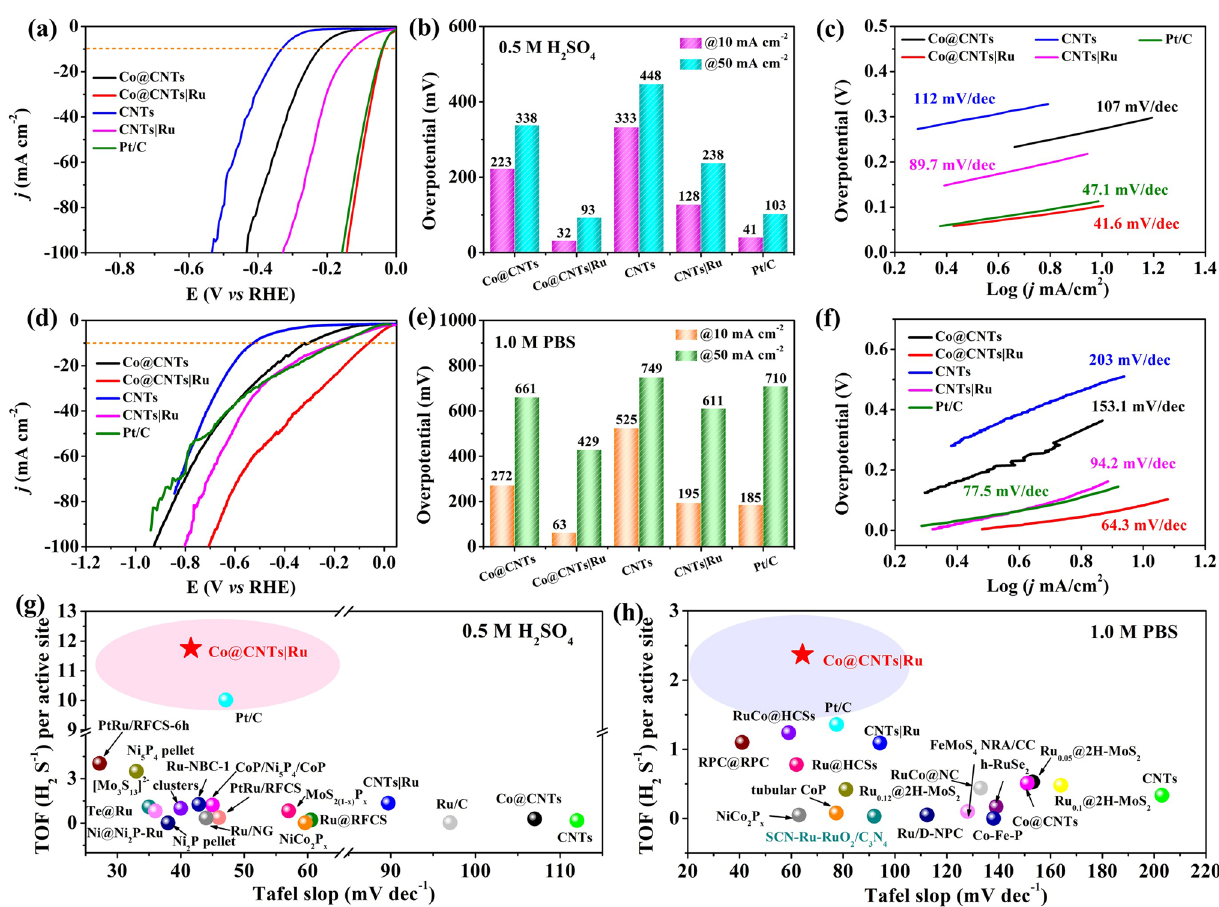
Fig. 5 a LSV curves, b overpotentials at a current density of 10 mA cm −2 , c Tafel plots of Co@CNTs, Co@CNTs|Ru, CNTs, CNTs|Ru and Pt/C electrocatalyst in 0.5 M H 2 SO 4 solution; d LSV curves, e overpotentials at a current density of 10 mA cm −2 , f Tafel plots of Co@CNTs, Co@ CNTs|Ru, CNTs, CNTs|Ru and Pt/C electrode in 1.0 M PBS solution; g − h TOF values of Co@CNTs, Co@CNTs|Ru, CNTs, CNTs|Ru, Pt/C catalysts and other recently reported HER electrocatalysts under a overpotential of 100 mV in 0.5 M H 2 SO 4 and 1.0 PBS